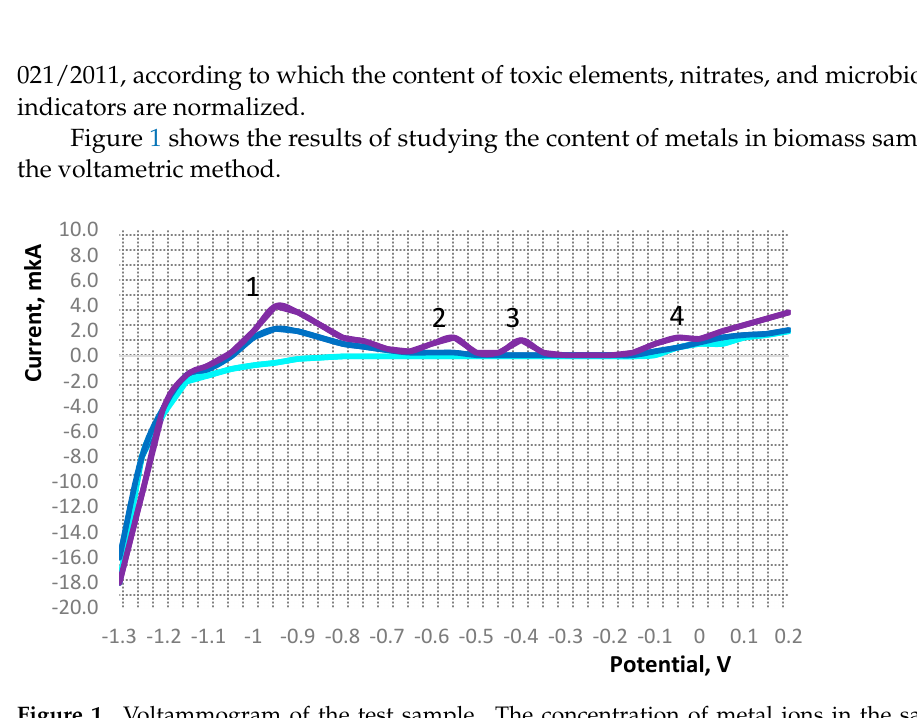
Figure 1. Voltammogram of the test sample. The concentration of metal ions in the sample is proportional to the peak area on the curve: background electrolyte; sample solution; sample with the addition of the target substance with a known concentration. 1–Zn, 2–Cd, 3–Pb, 4–Cu.